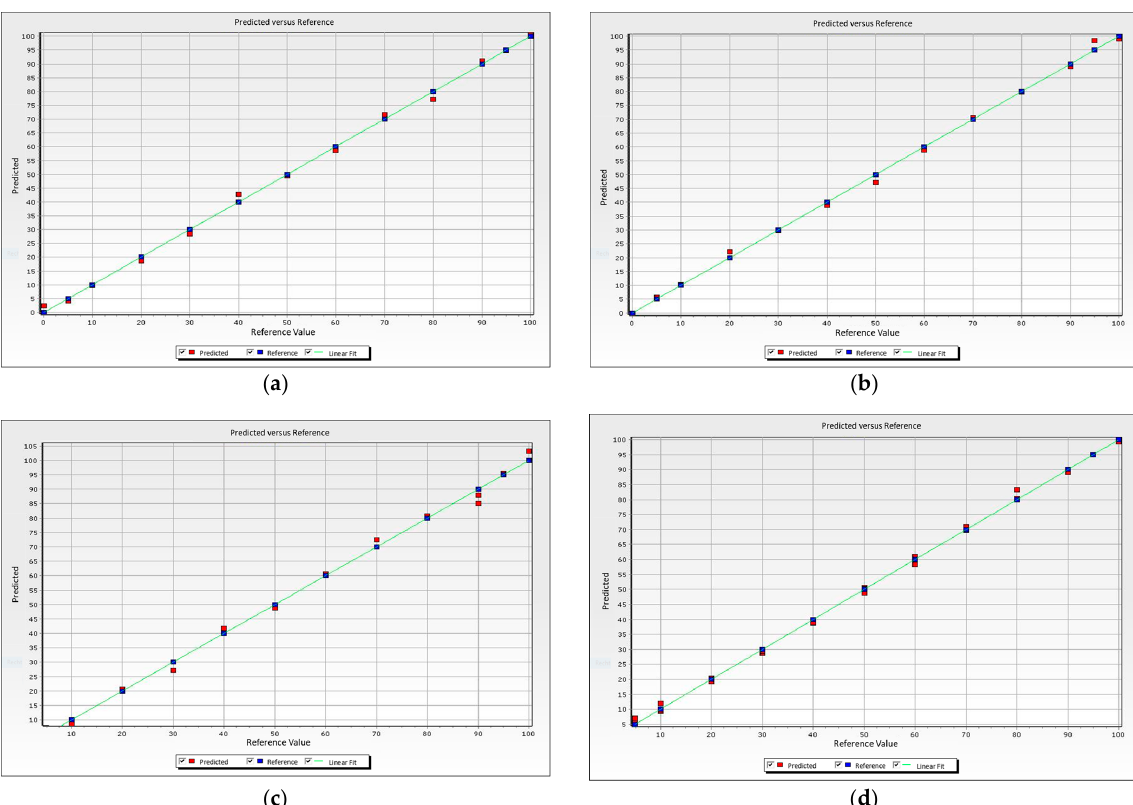
Figure 31. ( a ) Calibration curve of binary system orthoclase–quartz, ( b ) calibration curve of binary system orthoclase– spodumene, ( c ) calibration curve of binary system spodumene-quartz, and ( d ) calibration curve for spodumene in ternary mixtures orthoclase–spodumene–quartz.